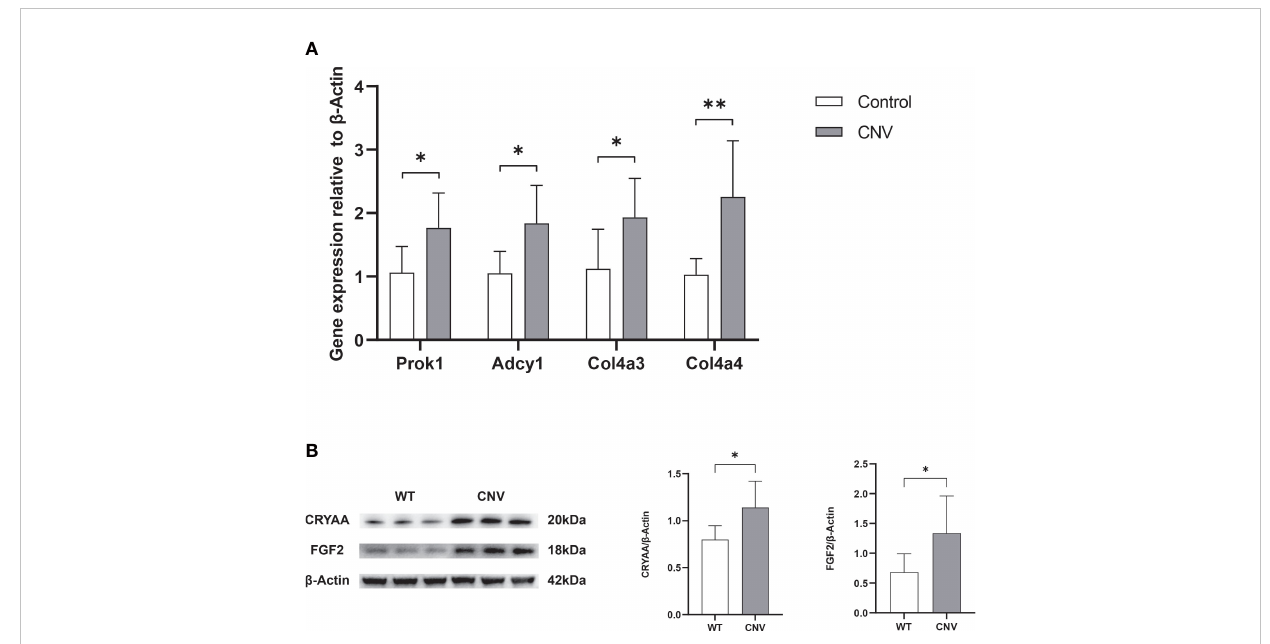
FIGURE 4 Veri fi cation of selected genes and proteins. (A) RNA expression of Prok1, Adcy1, Col4a3, and Col4a4 was measured in retinas using qPCR. n = 6; mean ± SD; Student ’ s t -test; * p < 0.05, ** p < 0.01. (B) The content of Cyraa and FGF2 proteins in retinas was detected by Western blot. n = 6; mean ± SD; Student ’ s t -test; * p < 0.05, ** p < 0.01. qPCR, quantitative real-time